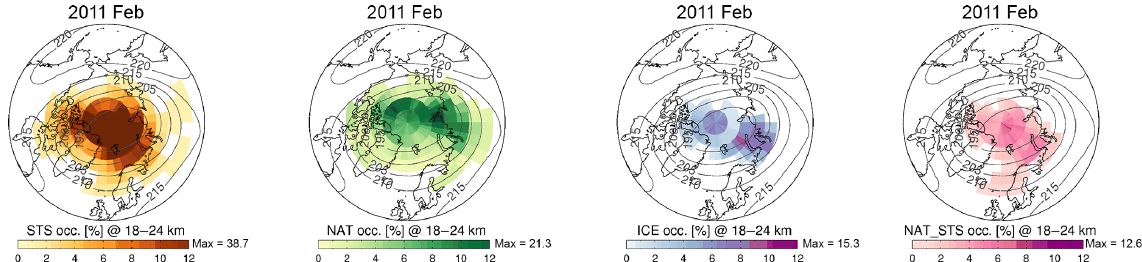
Figure 10. Similar representation of the MIPAS Bayesian classifier PSC classes like in Fig. 9 but for February 2011 only. All PSC classes use the same minimum/maximum values for the colour bar. Maximum values for STS and NAT are significantly larger (38.7 and 21.3%) than the maximum colour code value